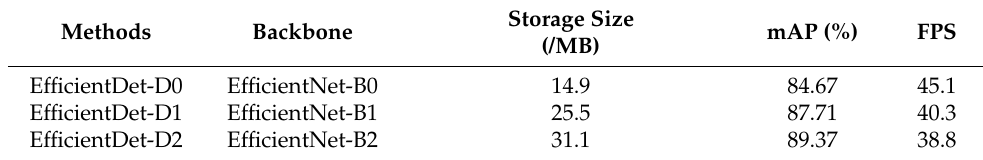
Table 1. The experimental results for different versions of EfficientDet.